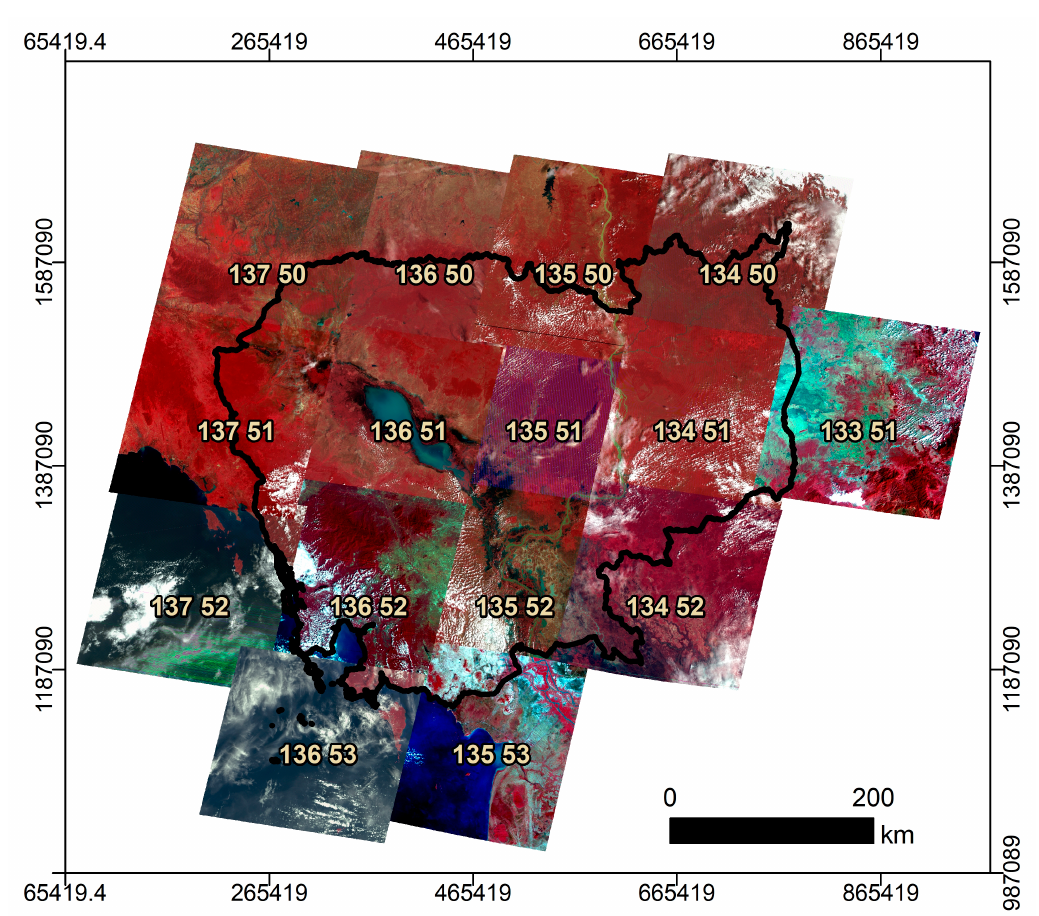
Figure 2. A mosaic of fifteen Landsat scenes was needed to provide national coverage of Cambodia.